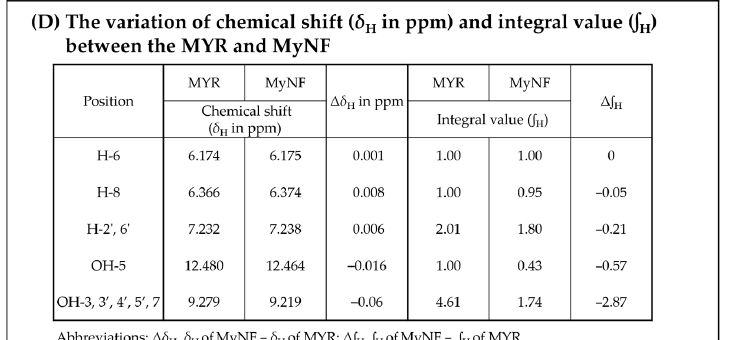
Figure 6. 1 H-nuclear magnetic resonance ( 1 H-NMR) spectra of ( A ) MYR, ( B ) blank (HPBCD: PVP; 20:12; w / w ), ( C ) MyNF (MYR: HPBCD: PVP; 1: 20: 12; w / w / w ), and ( D ) variation of chemical shift ( Δδ H in ppm) and integral value between the MYR and MyNF. Note: Pink color represents H-6; Green color represents H-8; Yellow color represents H-2 ′ , 6 ′ ; Blue color represents OH-3, 3 ′ , 4 ′ , 5 ′ , 7; purple color represents OH-5.